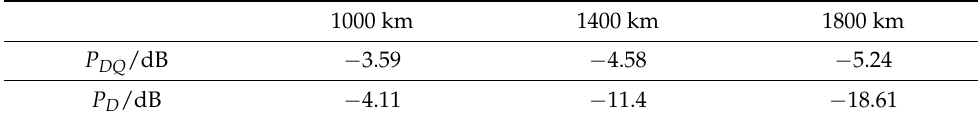
Table 4. The mean probability of 4 π direction for different distances.